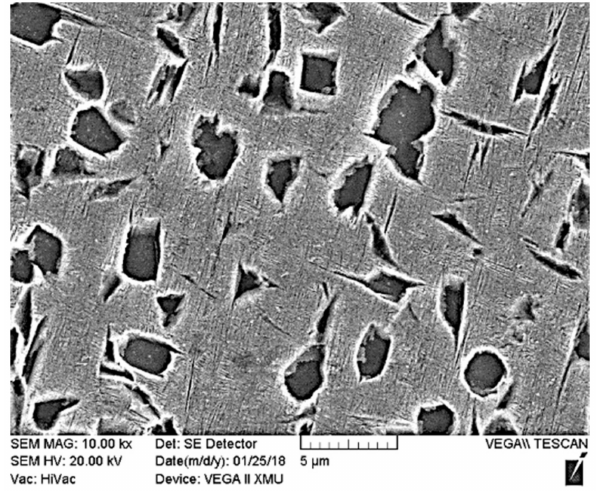
Figure 8. Microstructures of Ti55531 base metal (BM) after